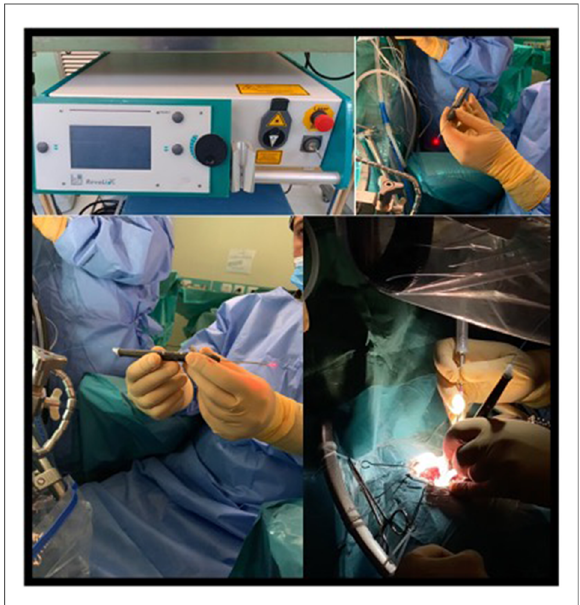
FIGURE 1 The 2-µm thulium laser device. Top left: console. Top right and bottom left: handheld device showed by GC. Bottom right, pic during active using on the surgical fi eld. Among its features, we underline the compact presentation, which requires little space in the OR, and the transmission through optic fi ber, which can fi t in handheld and endoscopic